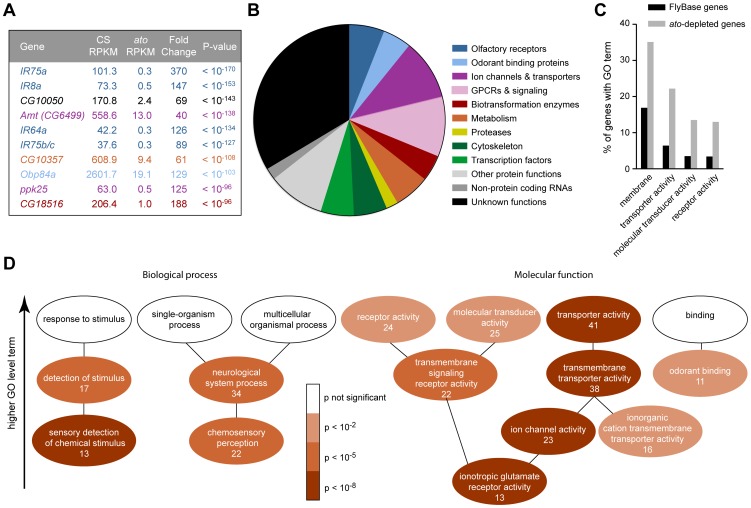
Functional categorization of 250 genes depleted in ato.
(A) The ten genes that show the most signification depletion in ato, based on p-value. Each is color-coded according to the categories in panel (B). (B) Categorization of the 250 genes that show at least four-fold reduction in ato with a FDR <0.01. Putative functions were determined by examination of automated gene annotation and BLAST searches to identify similar proteins. (C) Gene Ontology (GO) term analysis using the program AmiGO identified four level two terms that were significantly enriched among the 250 ato-depleted genes compared to all D. melanogaster genes listed in FlyBase. See Figure S7 for the complete analysis of all level two GO terms. (D) Significance of enrichment of lower level terms, which form a subset of higher level terms (e.g. “detection of stimulus” is a subset of “response to stimulus”). Lower level terms were selected to illustrate the types of functions most enriched in the dataset. The number of ato-depleted genes annotated with each GO term is indicated. We note that the ion channel genes depleted in ato include two members of the ppk family, ppk25 and ppk10, two members of the Trp family, nanchung and inactive, and four potassium channel genes: shaw-like (shawl), TWIK-related acid-sensitive K+ channel (Task7), Inwardly rectifying potassium channel 1 (Irk1), and CG1756. Depleted genes described by “transmembrane signaling receptor activity” included six GPCRs: 5-HT2, 5-HT7, CG43795, frizzled 3 (fz3), Pigment-dispersing factor receptor (Pdfr), and CG18208.